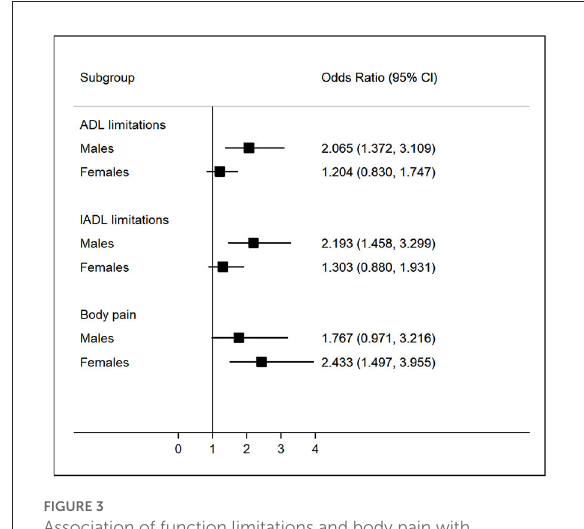
FIGURE3 Association of function limitations and body pain with depression among patients with stroke stratified by